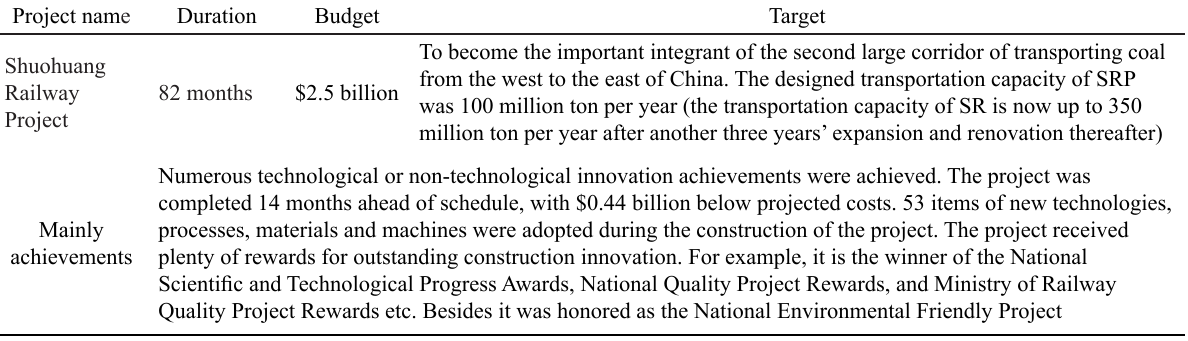
Table 2. Introduction of the case study project Project